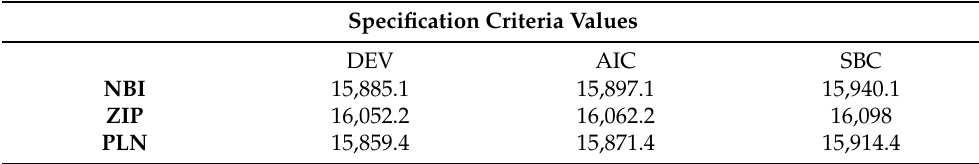
Table 3. ZIP regression model and NBI and PLN regression models